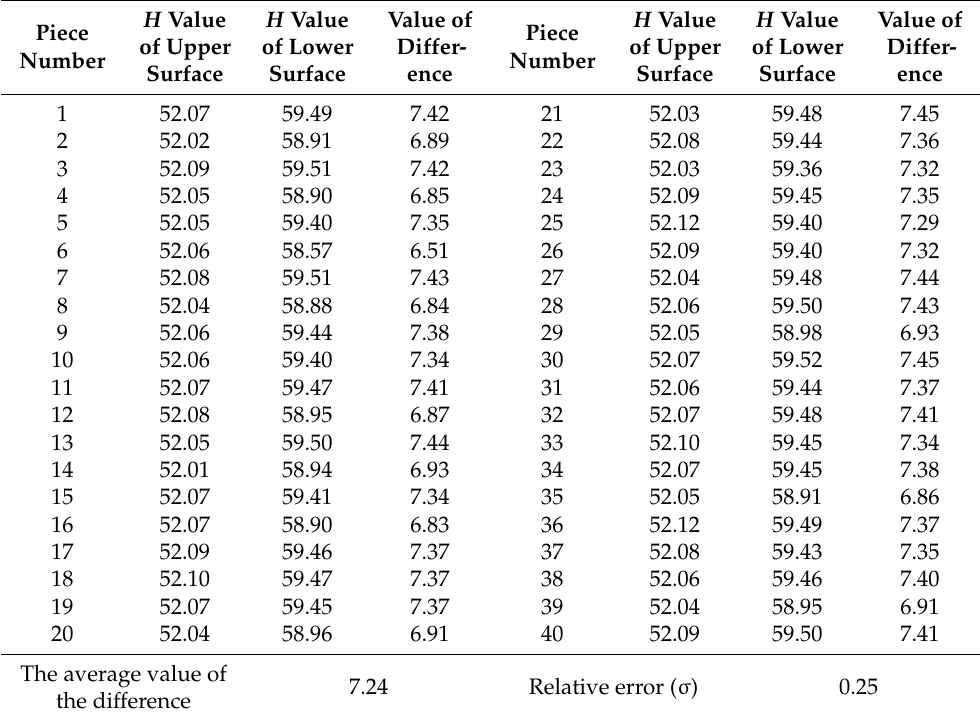
Table 5. Experimental data of the thickness of Slide 2.